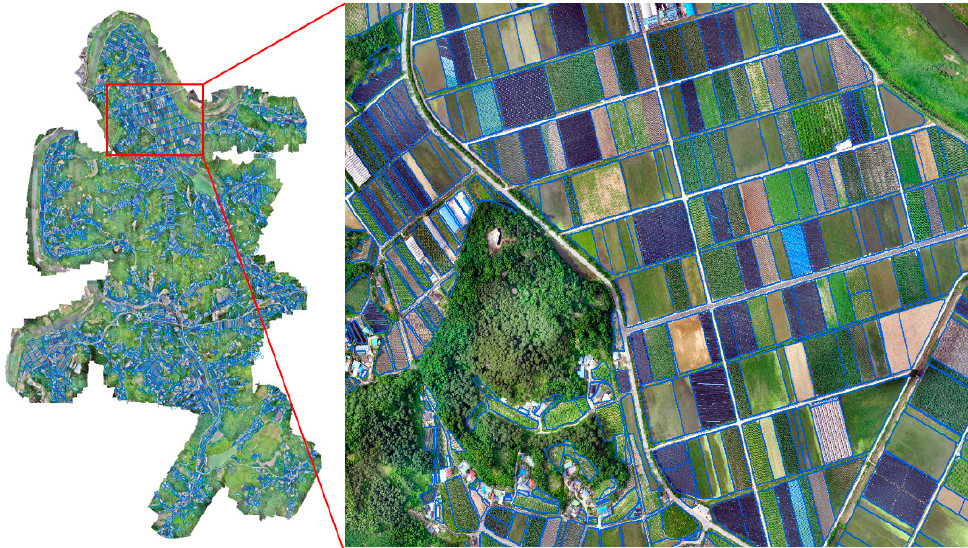
Figure 4. A farmland map that superimposes UAV orthogonal images taken of the study area and a Farm Map.